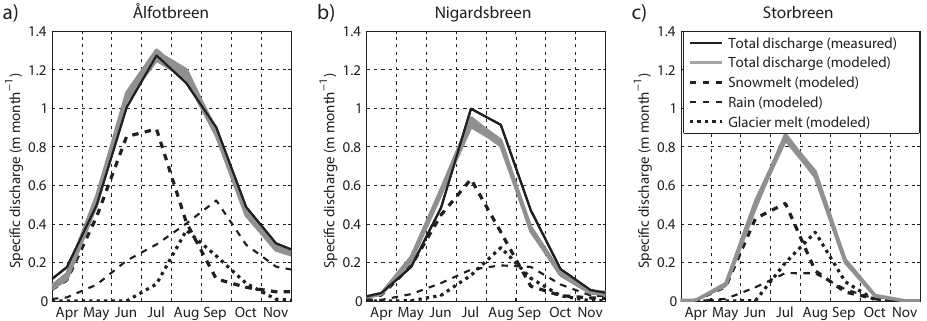
Fig. 10. Modelled monthly discharge rates and their contributing sources for Ålfotbreen, Nigardsbreen and Storbreen averaged for the period 2001-2010. Data for the contributing sources represent the mean of the best 100 model runs.